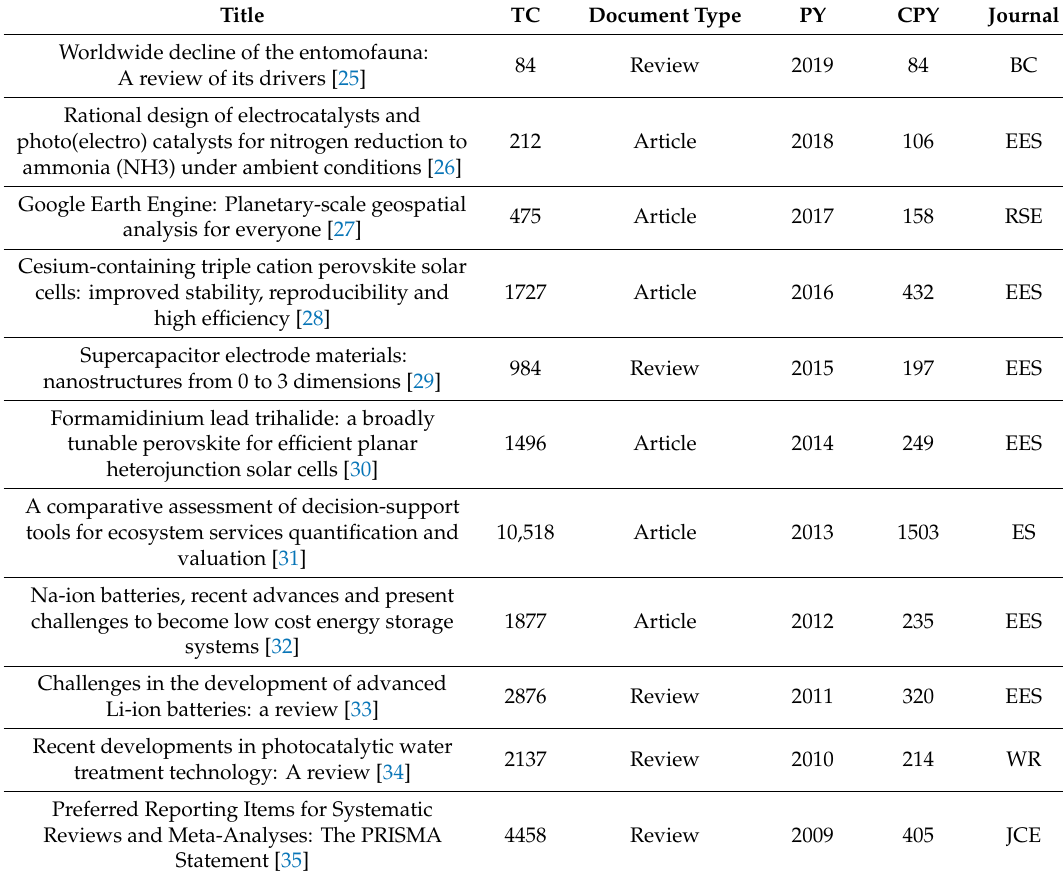
Table 4. Top cited paper in each